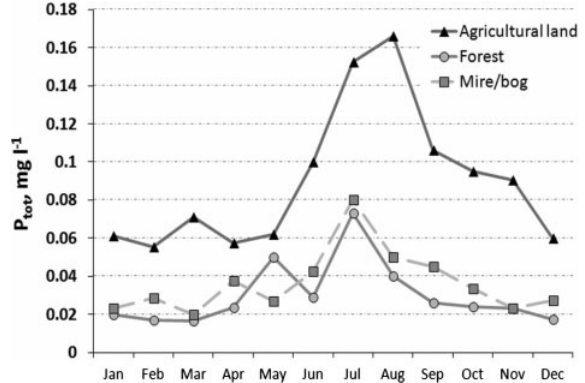
Fig. 4. Total nitrogen type-specific concentrations for diffuse source pollution